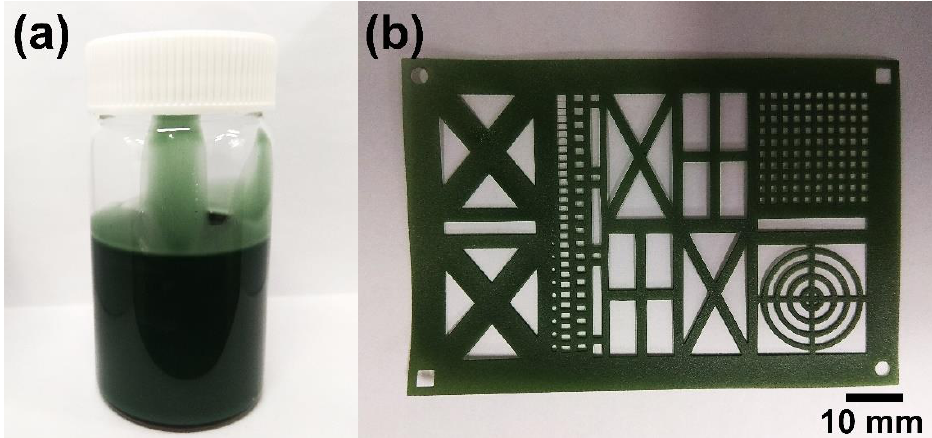
Figure 2. Digital images of ( a ) a conducting resin solution and ( b ) a 3D printed sculpture. Figure 3 shows FE-SEM images of PANI, graphene, pristine polyacrylate, and